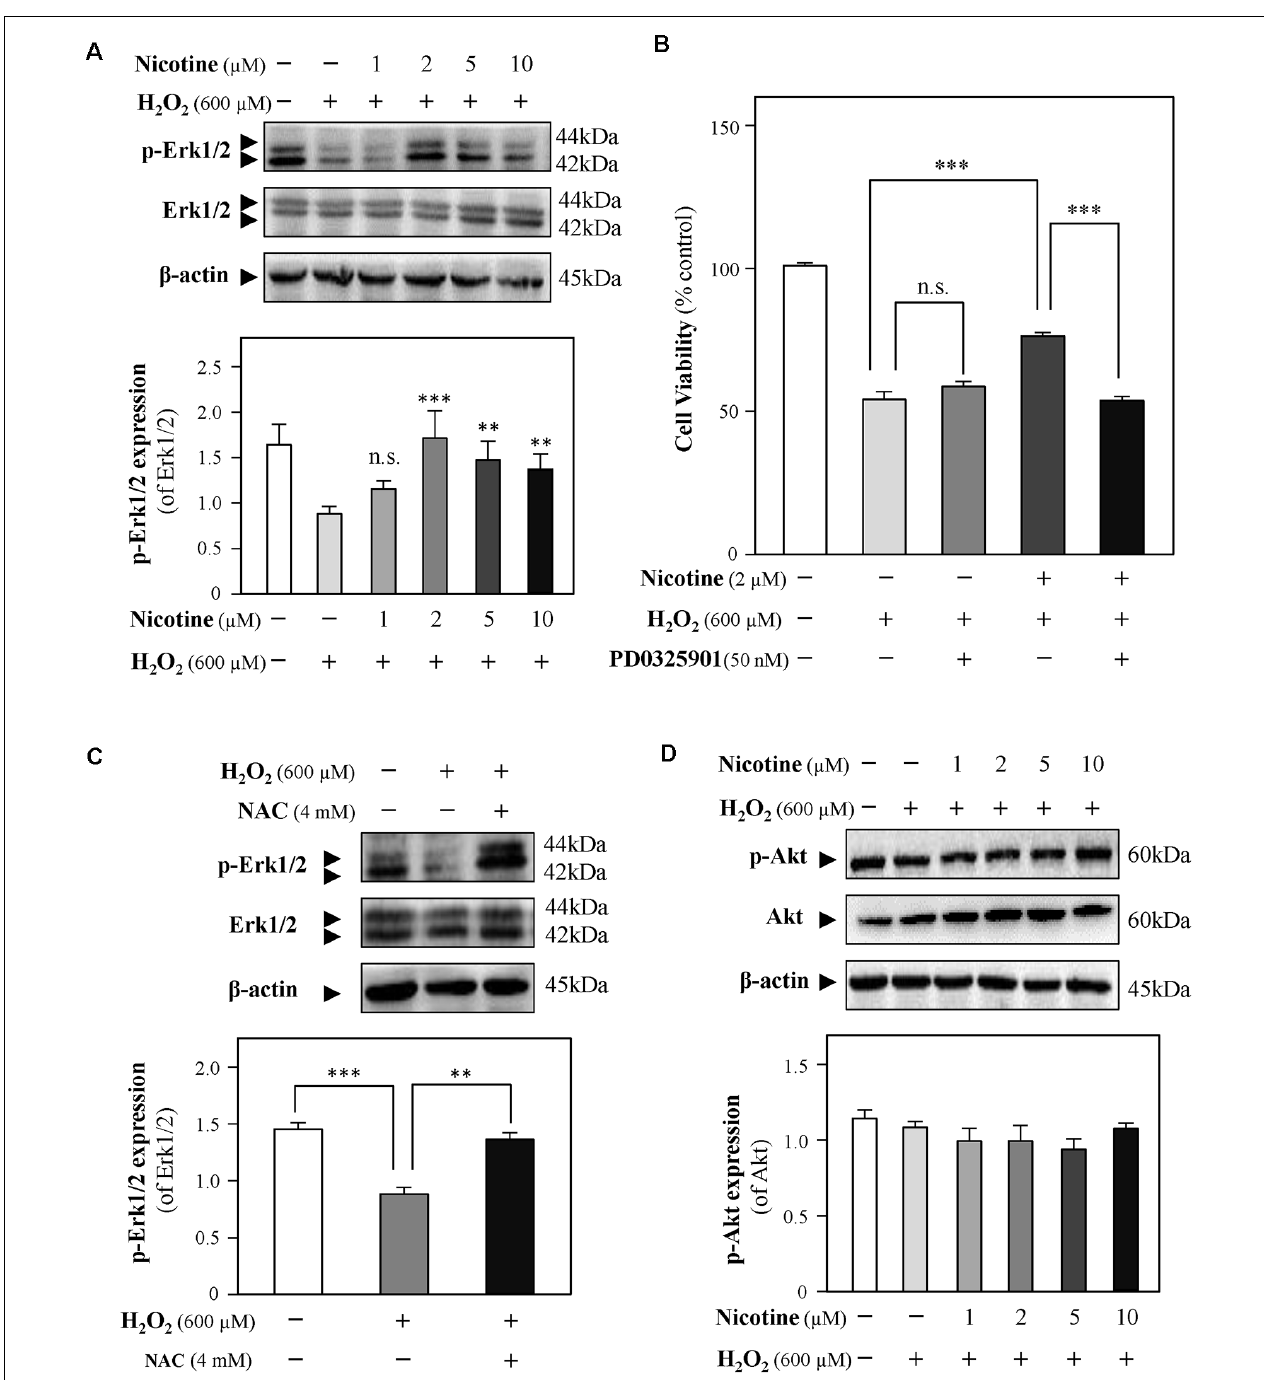
FIGURE 5 | Nicotine reverses H 2 O 2 -induced oxidative damage through the Erk signaling pathway. Cultured HT-22 cells were treated with or without nicotine (1, 2, 5, and 10 µ M) for 24 h, followed by H 2 O 2 (600 µ M) treatment in the presence or absence of PD0325901 (an inhibitor of Erk1/2, 50 nM) for 24 h or in the presence or absence of NAC (4 mM) for 24 h. The control group consists of the untreated cells. (A) The protein expressions of p-Erk1/2 and Erk1/2 were determined by western blotting (upper panel). Expression of β -actin served as loading control. The quantitation of p-Erk1/2 and Erk1/2 expressions was calibrated (lower panel). (B) Cell viability test was performed using CCK-8 kit, and the changes were shown in histograms as percentage with control. (C) The protein expressions of p-Erk1/2 and Erk1/2 were determined by western blotting (upper panel). Expression of β -actin served as loading control. The quantitation of p-Erk1/2 and Erk1/2 expressions was calibrated (lower panel). (D) The protein expressions of p-Akt and Akt were determined by western blotting (upper panel). Expression of β -actin served as loading control. The quantitation of p-Akt and Akt expressions was calibrated (lower panel). All data in bar charts represent mean ± SEM, n = 3. ∗∗ p < 0.01, ∗∗∗ p < 0.001 vs. control group. NAC, N -acetylcysteine. n.s., no significance.